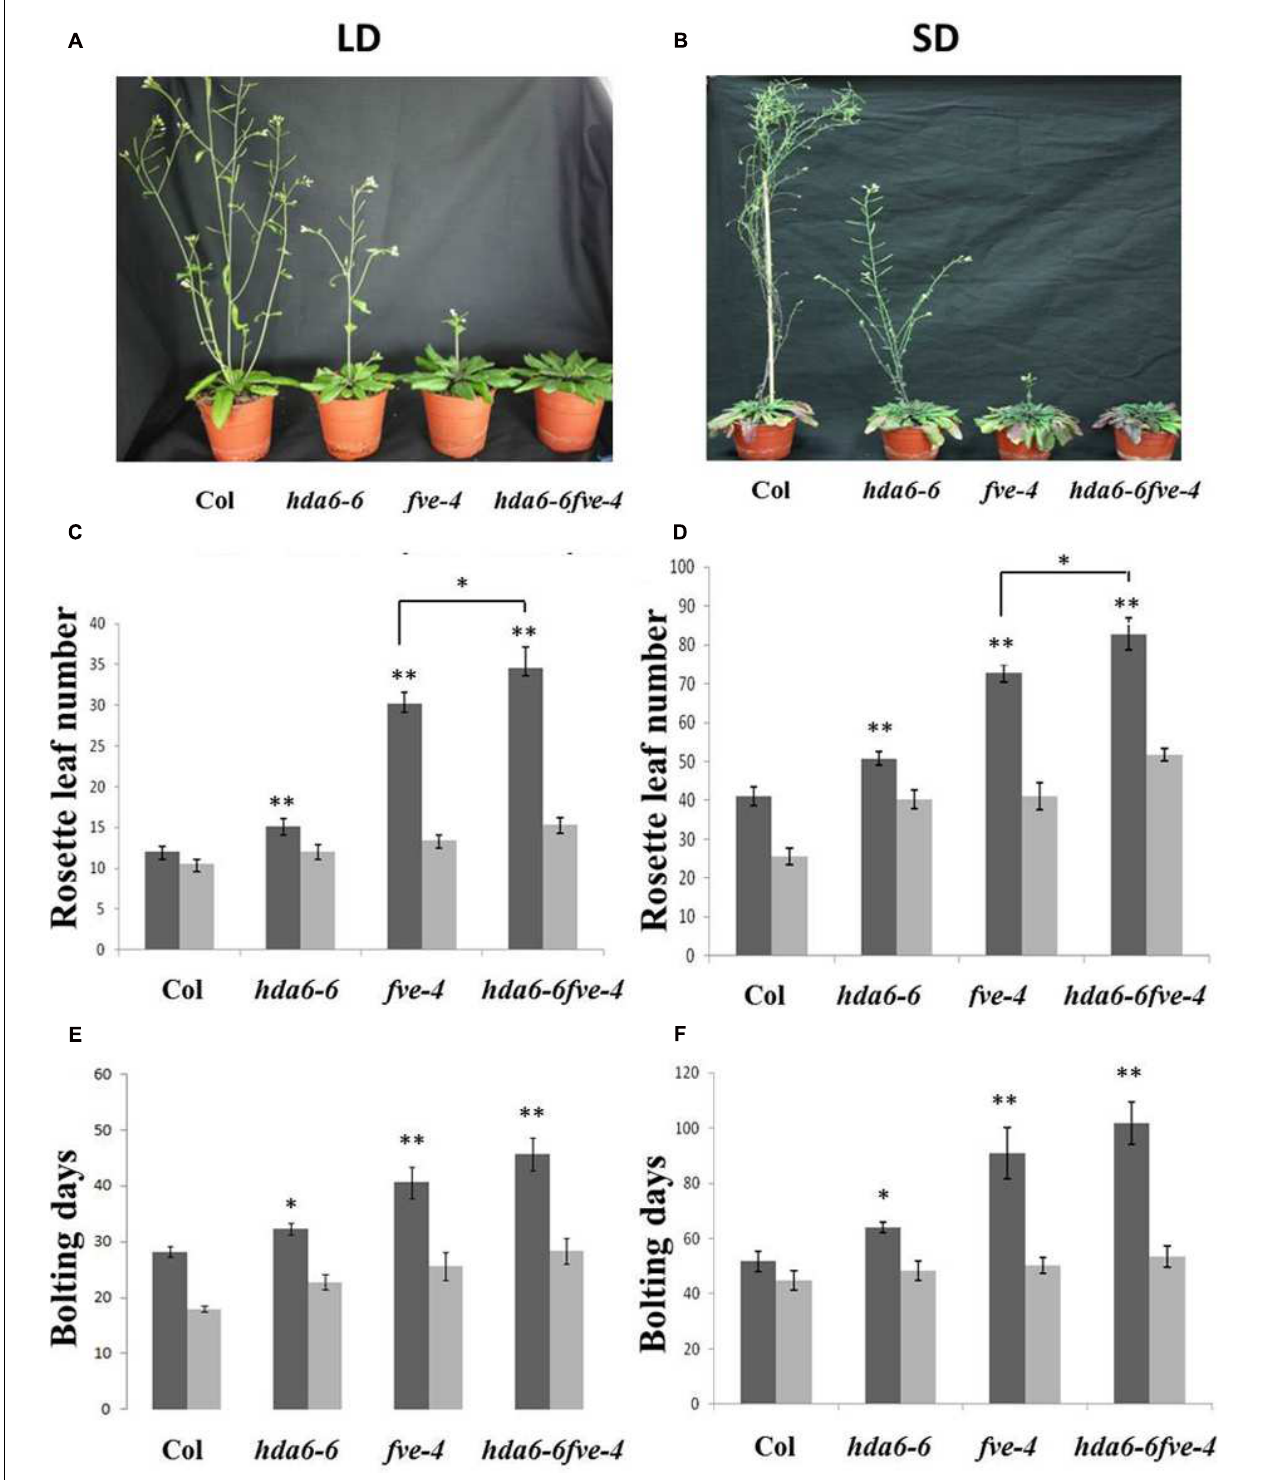
FIGURE 1 | Delayed flowering phenotypes of hda6-6 , fve-4 and hda6-6fve-4 plants. (A,B) hda6-6 , fve-4 , and hda6-6fve-4 plants grown under long day (LD) and short day (SD) conditions compared with Col wild type. (C–F) Rosette leaf numbers and bolting days of Col, hda6-6 , fve-4 , and hda6-6fve-4 plants grown under LD and SD without vernalization (black columns) or with 45 days vernalization (gray columns). At least 20 plants were scored for each line. Error bars indicate SD. ∗ P < 0.05, ∗∗ P < 0.01 ( t -test).